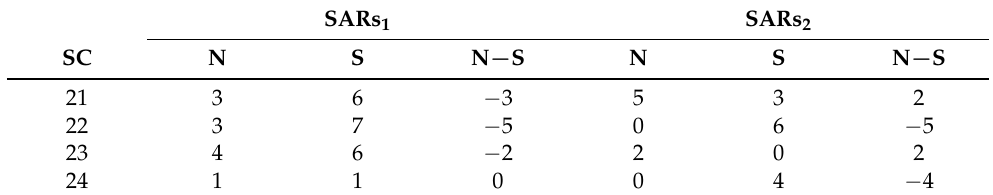
Table 2. The number of SARs 1 and SARs 2 in the two hemispheres and their difference during each SC.